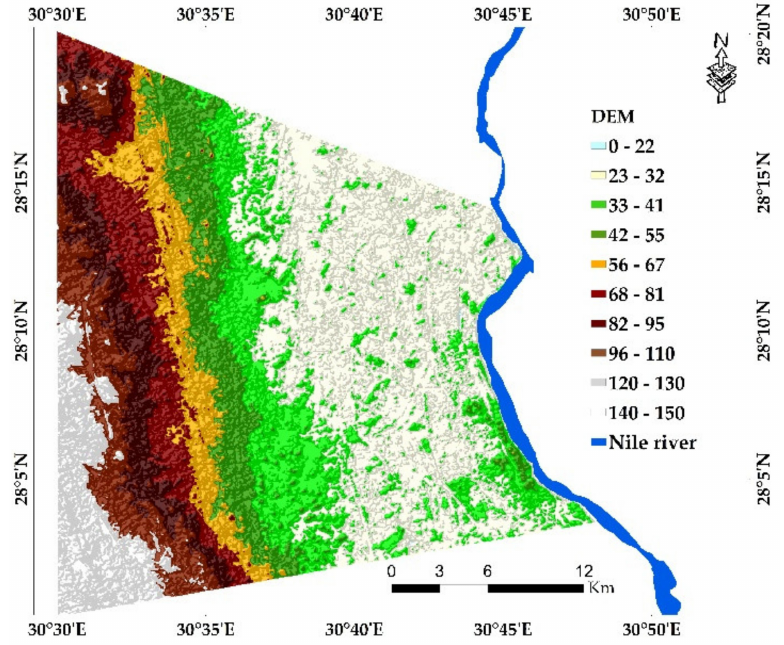
Figure 3. Digital elevation model (DEM) of area under